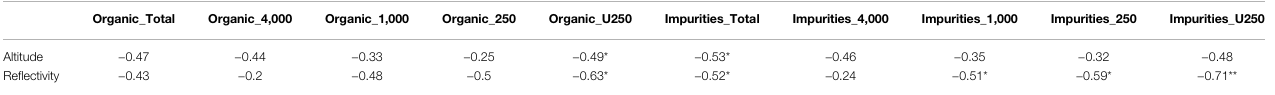
TABLE 1 | The Pearson correlation matrix between altitude, re fl ectivity, total impurity content and organic matter content. Each signi fi cance level ( p -value) is associated to a symbol: < 0.001: “ *** ” ; < 0.01: “ ** ” ; < 0.05: “ * ”